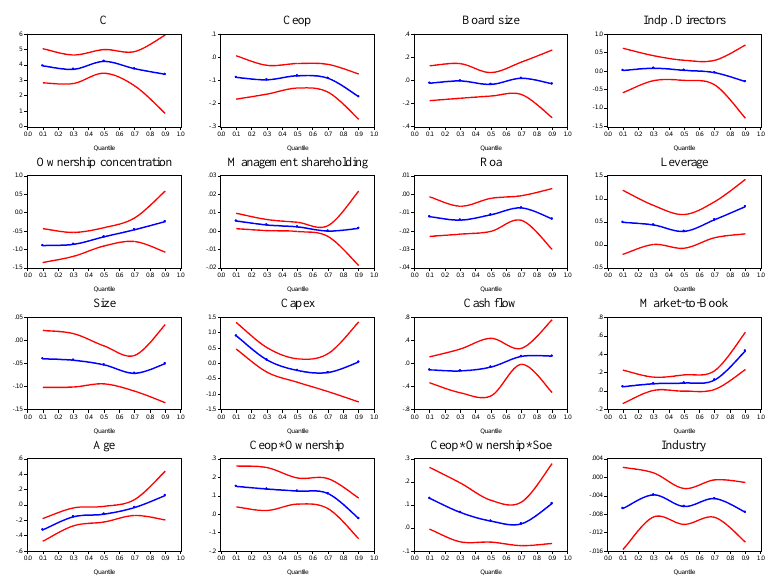
Figure 3. coefficient change of the parameters related to model 3 in various